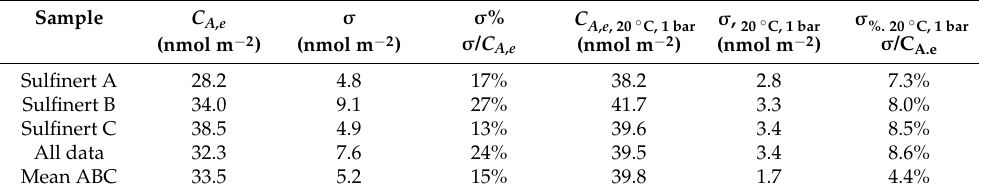
Table 4. Sulfinert ® Areic amount adsorbed ( C A,e ). Raw data and data corrected at 20 ◦ C 1 bar with experimental standard deviations for a single sample and all data